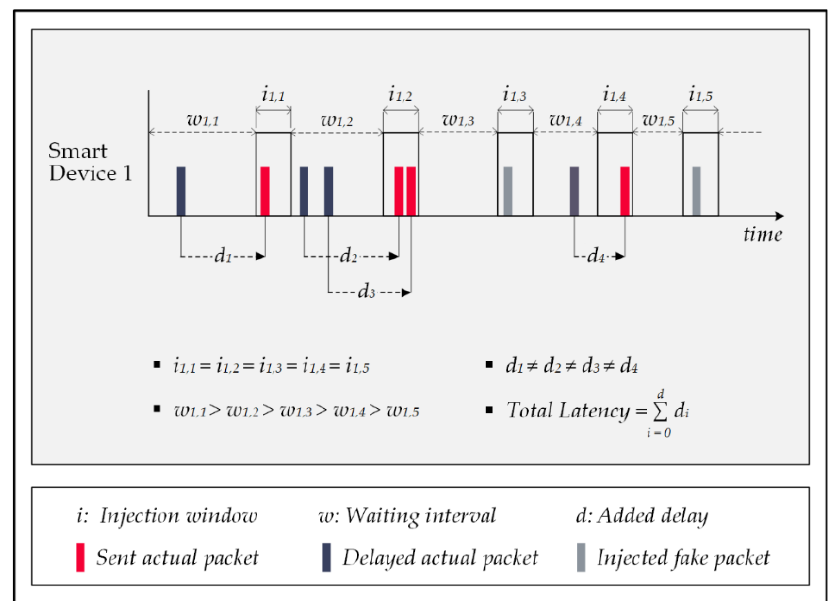
Figure 11. The ProbRate scheme.